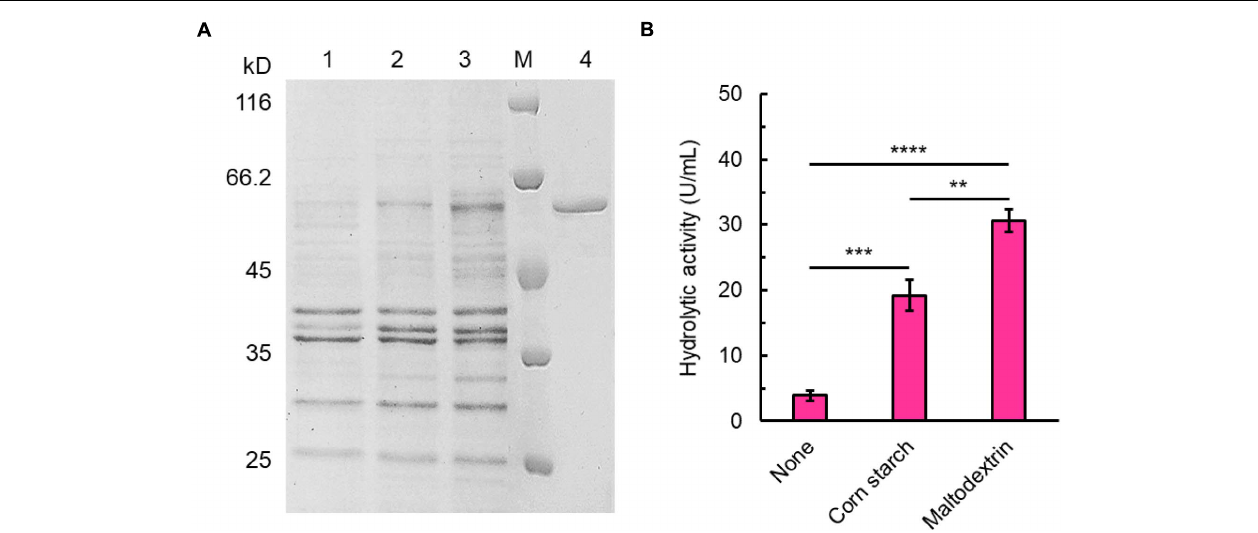
FIGURE 1 | Expression and purification of SdG5A. (A) SDS-PAGE analysis of SdG5A. Lane M, molecular-weight protein marker. Lane 1, culture supernatant collected from the basic expression medium; lane 2, culture supernatant collected from the expression medium containing 5 g L - 1 corn starch; lane 3, culture supernatant collected from the expression medium containing 5 g L - 1 maltodextrin; lane 4, purified SdG5A. (B) Hydrolytic activity of culture supernatant collected from the mediums with the indicated supplement. Each value represents the mean of three independent measurements (mean ± standard